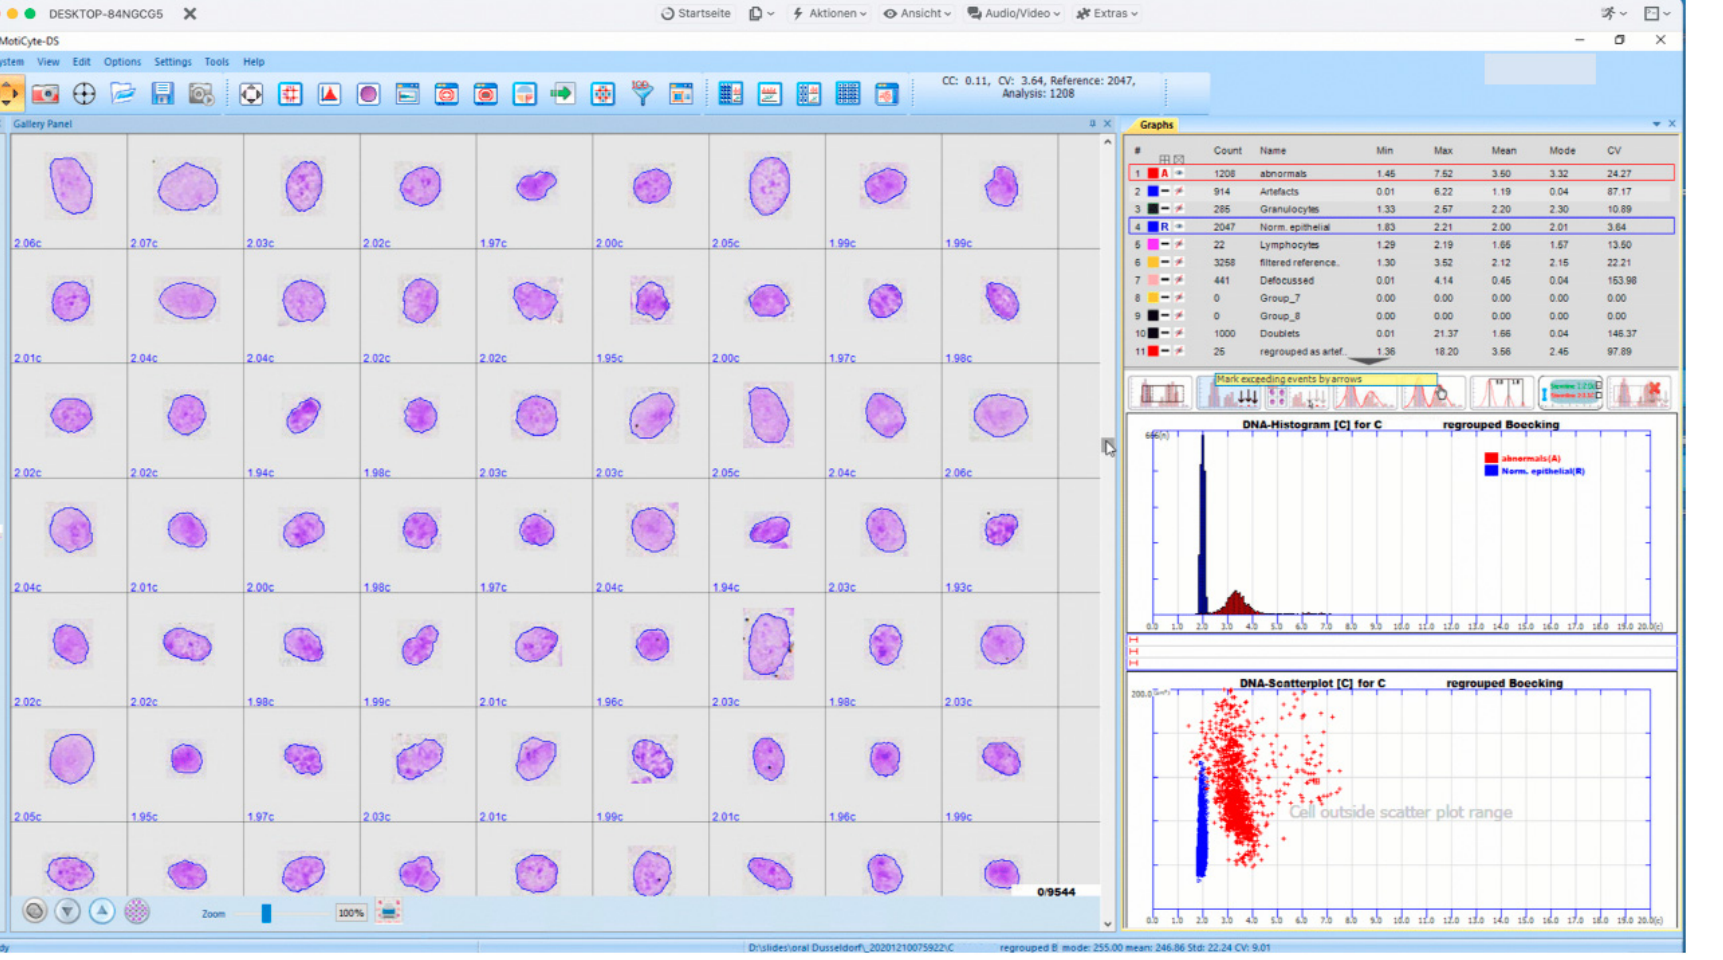
Figure 4. Interactive screen from an EasyScan-AI, presenting an image gallery of 63 automatically classified normal epithelial, Feulgen-stained nuclei from an oral smear, including their respective DNA contents ( left ), the respective DNA histogram and scattergram (area vs. DNA) ( right below ), and numbers plus different statistical features of detected five nuclear types ( right above ).